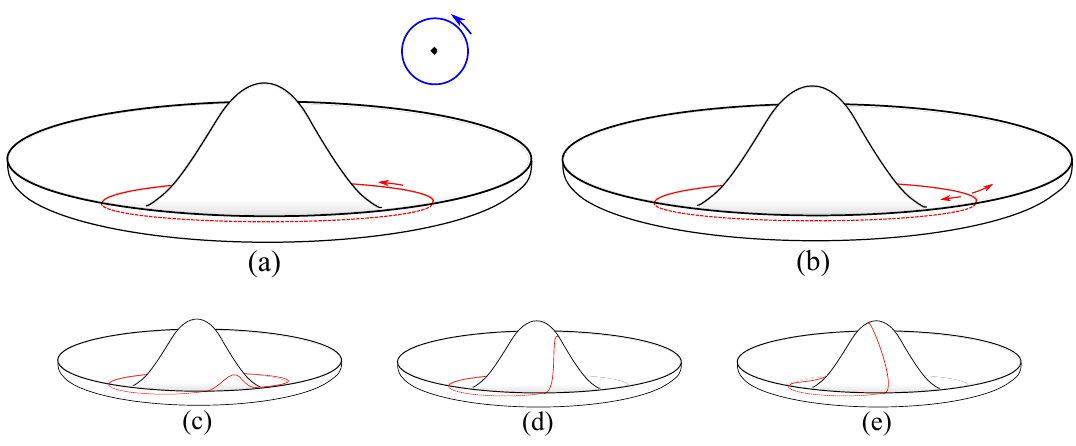
Figure 2 . This figure illustrates how the axion string can unwind. In (a), we show the winding solution for the axion string along a circle of fixed radius. As we go around the blue circle (a circle linking the axion string (black) in spacetime) the scalar field ϕ winds around the bottom of the mexican hat potential in red. (b) shows the excitations of the radial mode which is activated at the scale m . (c-e) shows a process by which we can unwind the scalar field. Here we deform ρ ∼ mf solution in the radial direction over the top of the potential which costs energy resulting configuration has no winding — indicating the decay of the